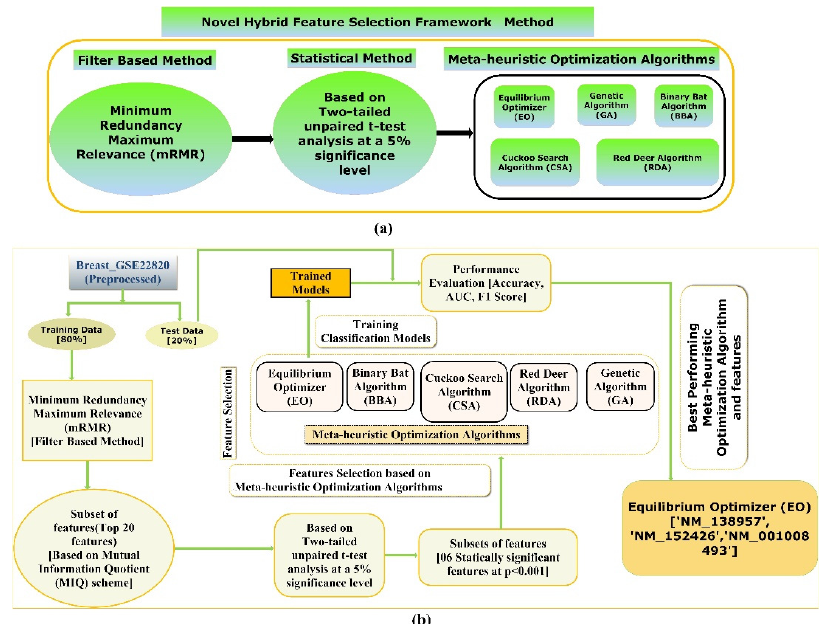
Figure 2. ( a ) An illustration demonstrating the proposed hybrid FS technique and ( b ) a diagram showing the workflow of the proposed method to screen the best hybrid FS methods and an efficient supervised classification-based model for classifying primary breast cancer samples from the nor- mal breast